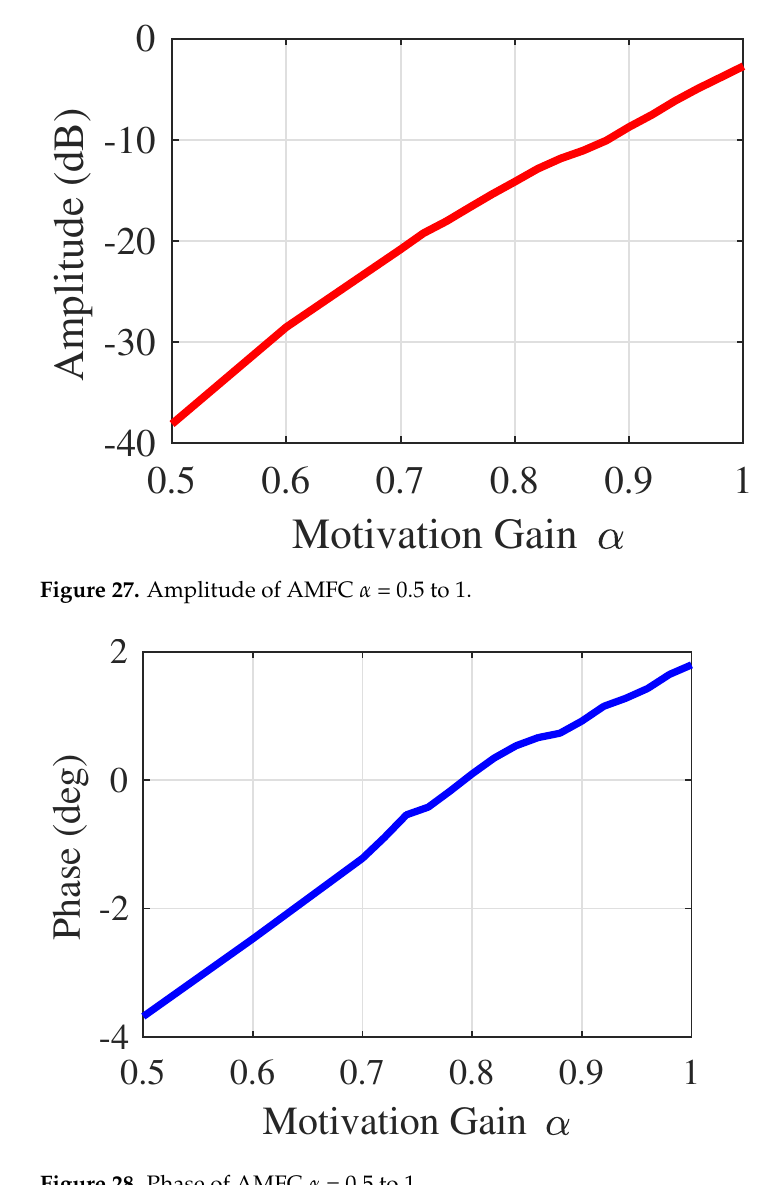
Figure 28. Phase of AMFC α = 0.5 to 1. Table 2. Experiment phase lag of PI, PID and